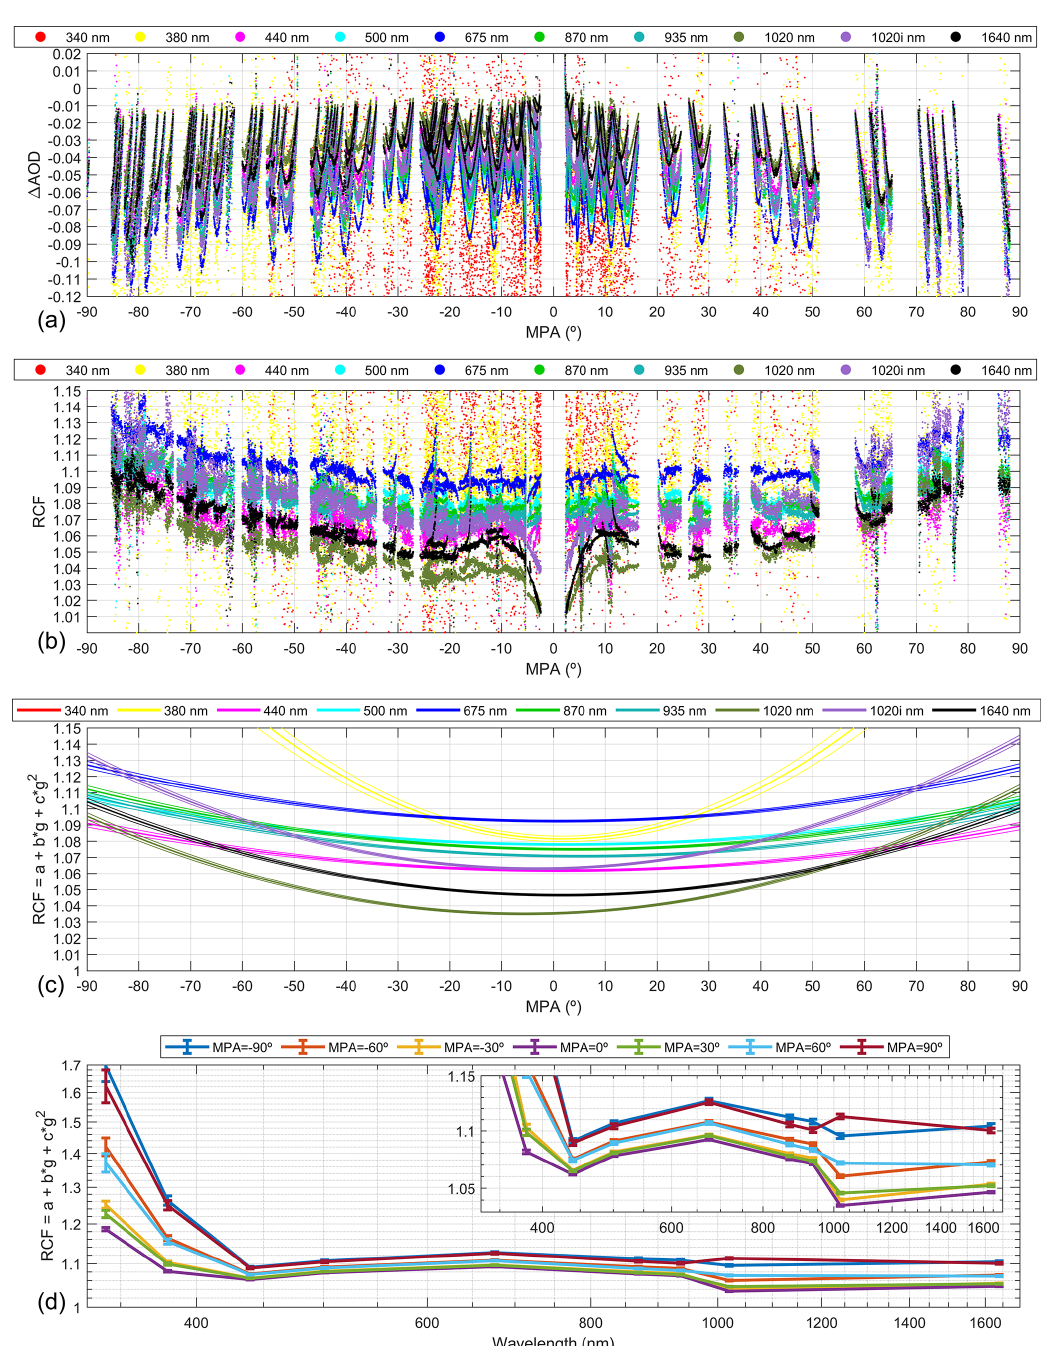
Figure 1. (a) Differences between AOD from gain calibration and the reference values at night as a function of Moon phase angle (MPA) for different wavelengths; (b) RIMO correction factor (RCF) against MPA for different wavelengths; (c) fitted RCF and ± its propagated uncertainty vs. MPA for different wavelengths (340nm values are not shown because they are out of the axis limits); and (d) fitted RCF and ± its propagated uncertainty (error bars) against the nominal wavelength of each CE318-T channel, for different MPA